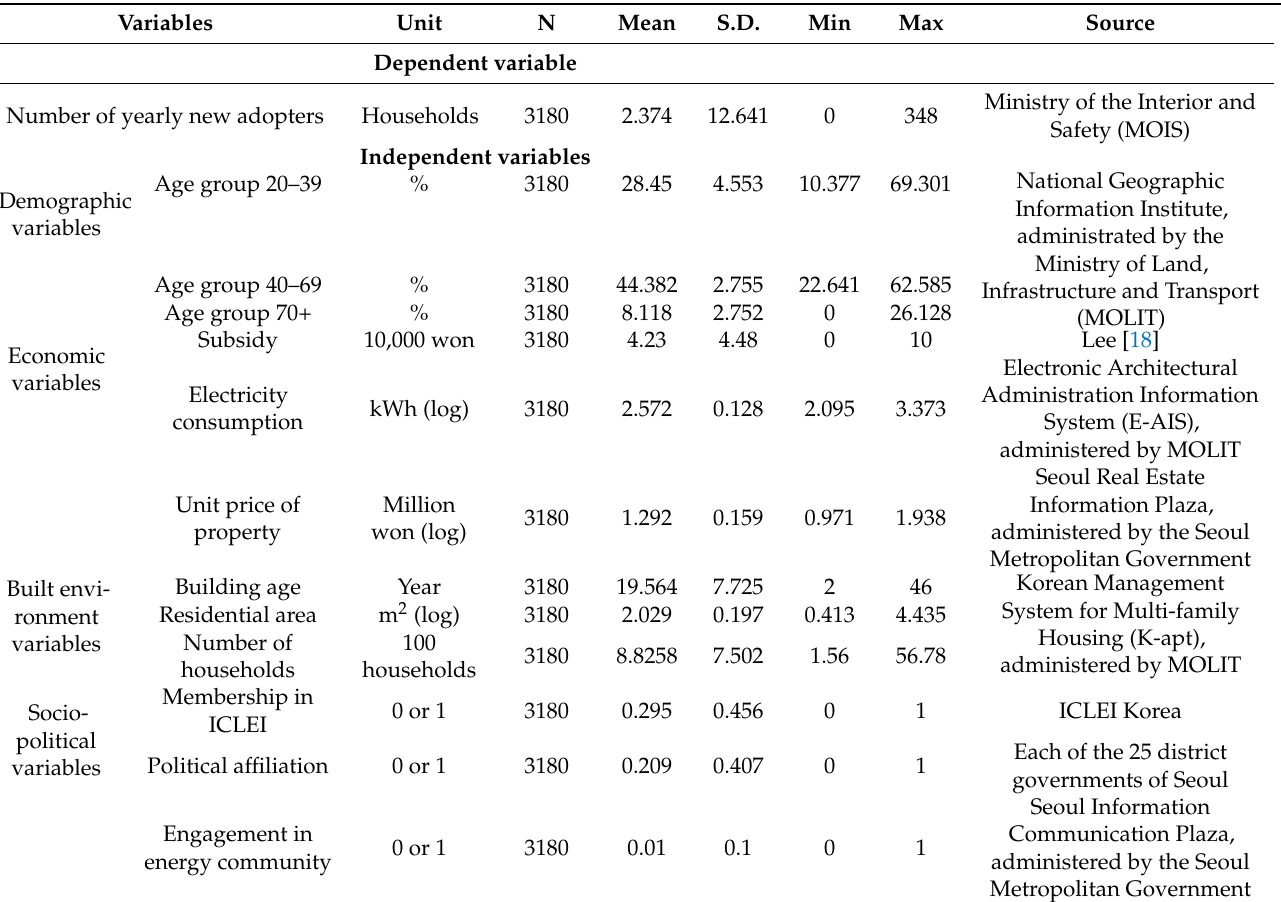
Table 1. Descriptive